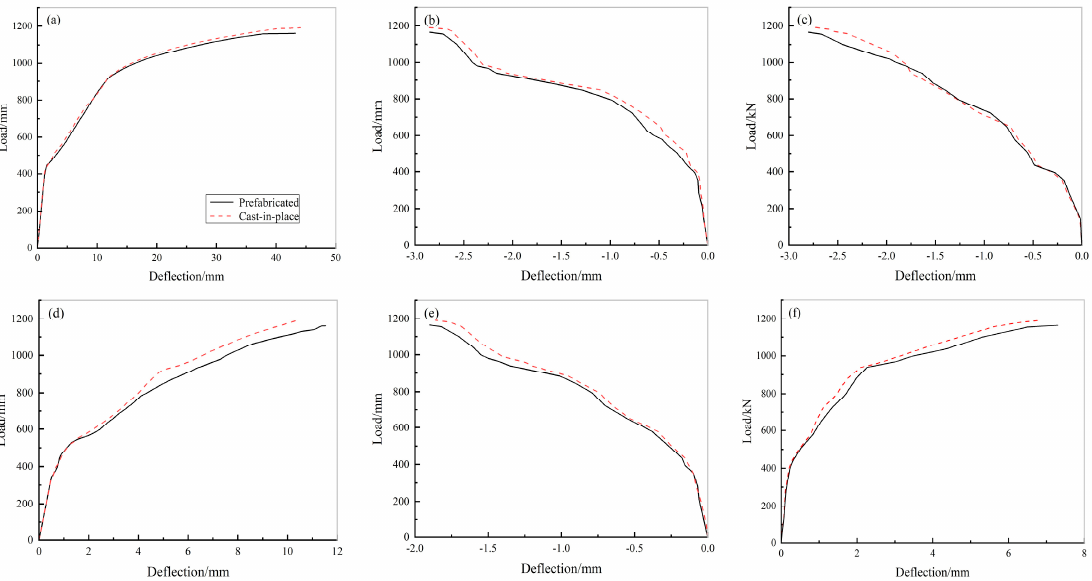
Figure 15. Load-deflection curves of cast-in-place and prefabricated underground utility tunnels: ( a ) load-deflection curve of large-span top plate; ( b ) load-deflection curve of small-span top plate; ( c ) load-deflection curve of large-span lateral wall; ( d ) load-deflection curve of large-span bottom plate; ( e ) load-deflection curve of small-span bottom plate; and ( f ) load-deflection curve of small-span lateral wall.